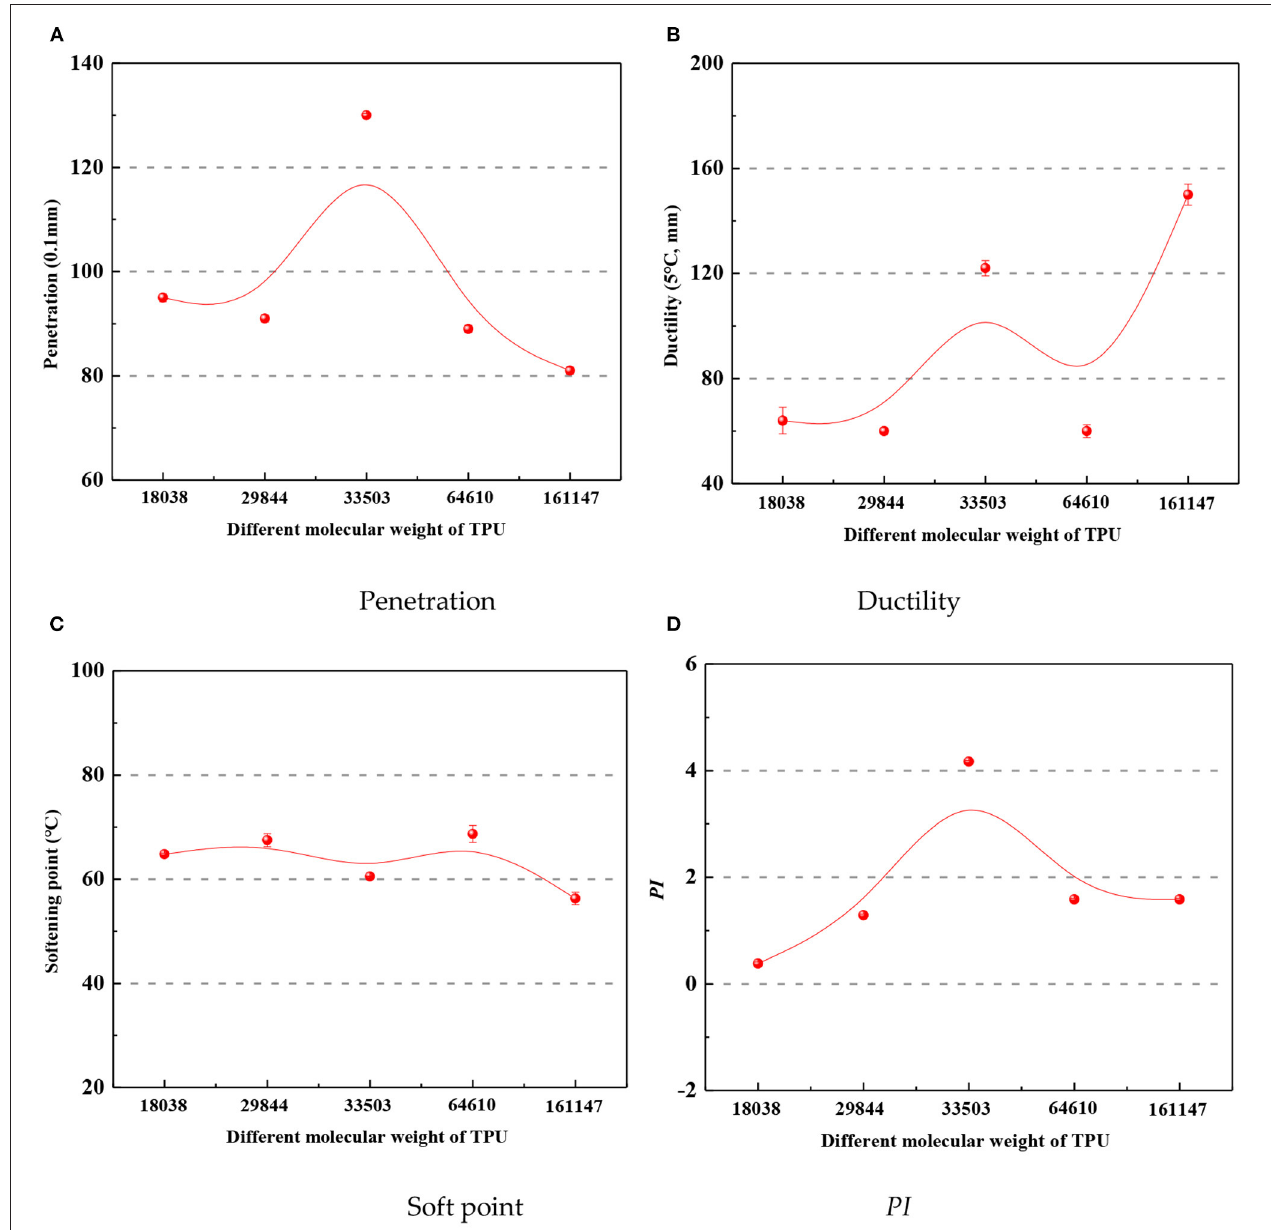
FIGURE 13 | Polyester-based TPU-modified asphalt. (A) Penetration. (B) Ductility. (C) Soft point. (D) PI